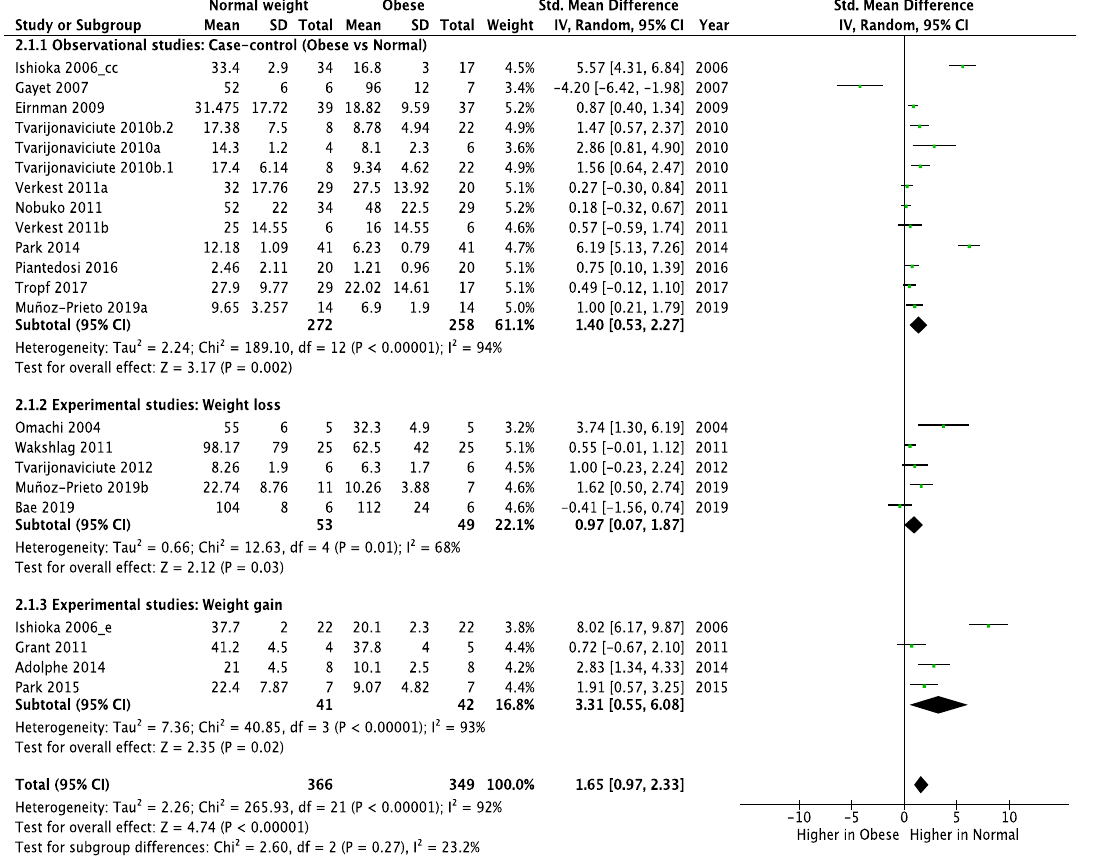
Figure 3. Subgroup (observational studies, i.e., case–control, and experimental studies, i.e., weight loss and weight gain) meta-analysis findings of circulating adiponectin concentrations in obese versus normal weight dogs. SD: Standard deviation; Std: Standardized; IV: Interval variable; CI: Confidence interval.